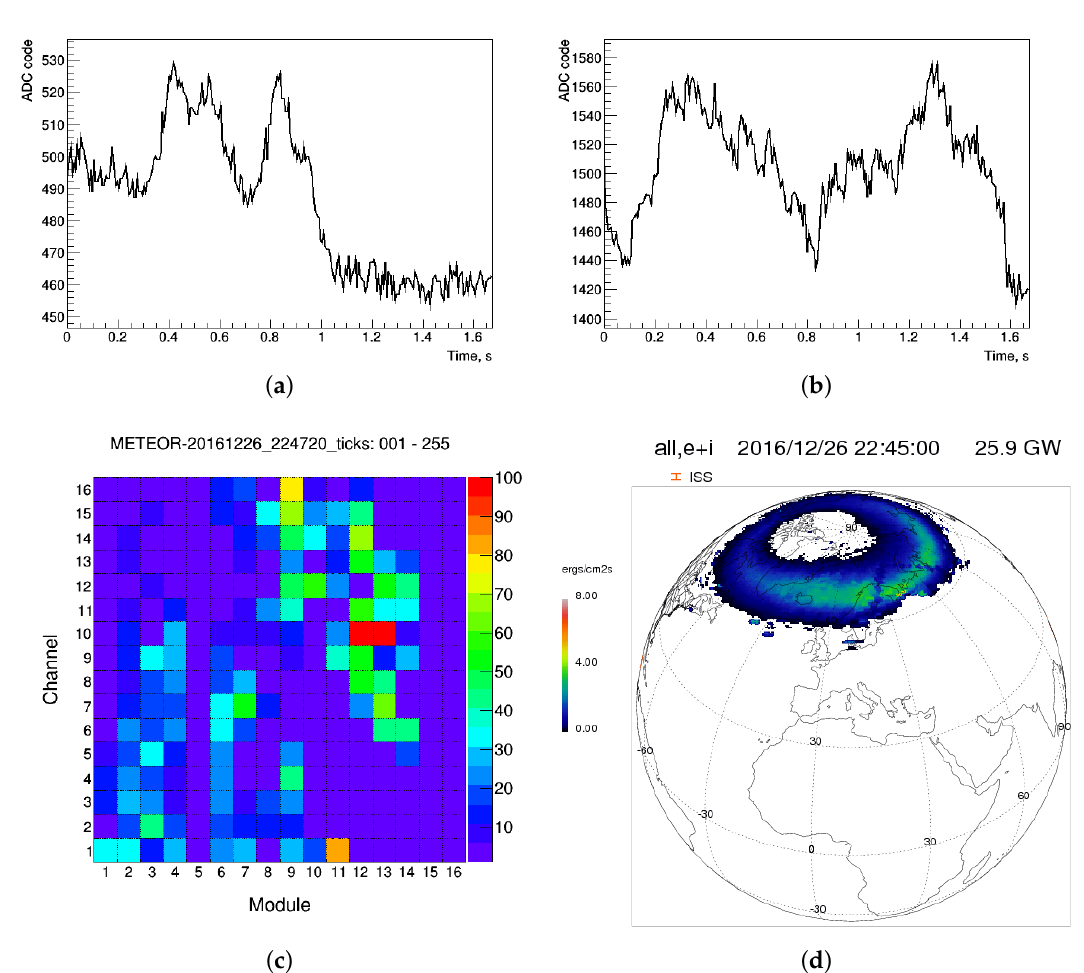
Figure 15. Example of Aurora light measurements. The ( a , b ) show waveforms of two hit pixels during the TUS passage above the aurora oval. The ( c ) shows a pixel map in the same passage above the aurora. The ( d ) shows density of electron flux in the polar region causing the polar light, see the